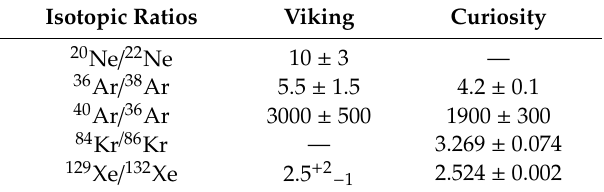
Table 4. The noble gas isotopic ratios as measured by the Viking [20] and Curiosity missions [31–41]. Isotopic